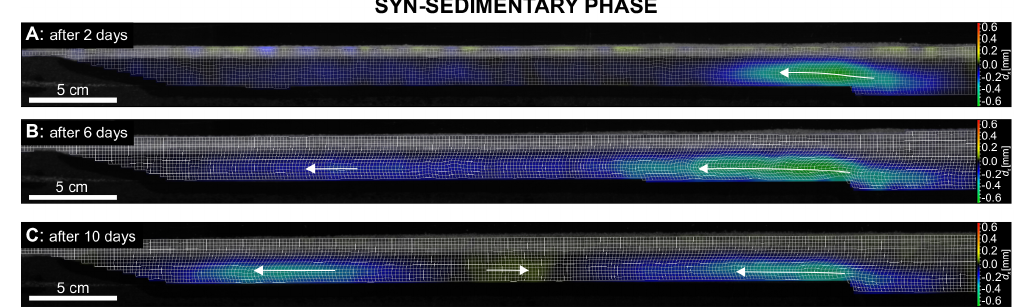
Figure 9. Time series of PIV displacement patterns of the reference experiment Exp. 1b during syn-sedimentary phase. (a) After 2 days, pronounced leftward (blue) directed movement occurs close to the basement fault tip. (b) After 6 days, the zone of leftward movement increases in width and additional flow appears away from the basement fault. (c) After 10 days, significant displacement can still be observed above the basement fault and away from it.